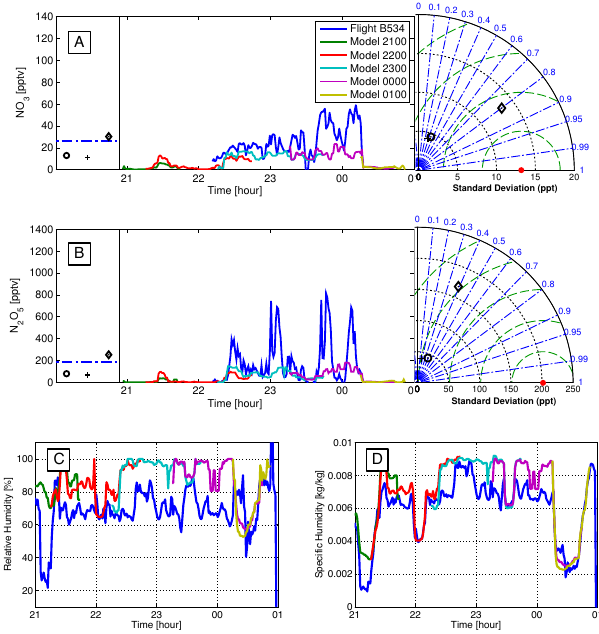
Figure 10. Flight track measurement–model comparisons and statistics for NO 3 and N 2 O 5 ( a and b , respectively), as well as com- parisons for relative and specific humidity ( c and d , respectively) for flight B534. Symbols representing the different model scenarios are the same as those used in Fig.